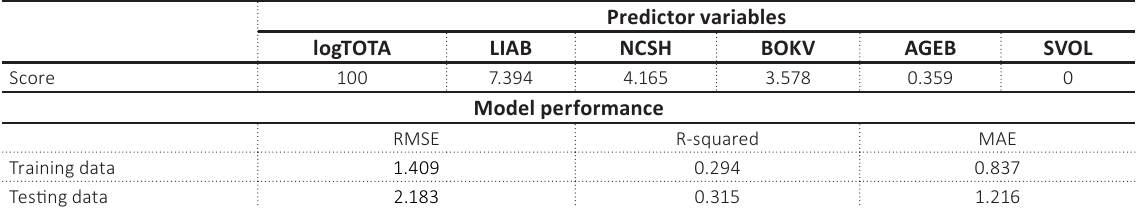
Table 3. Linear regression variable importance scores and performance metrics for EPS model